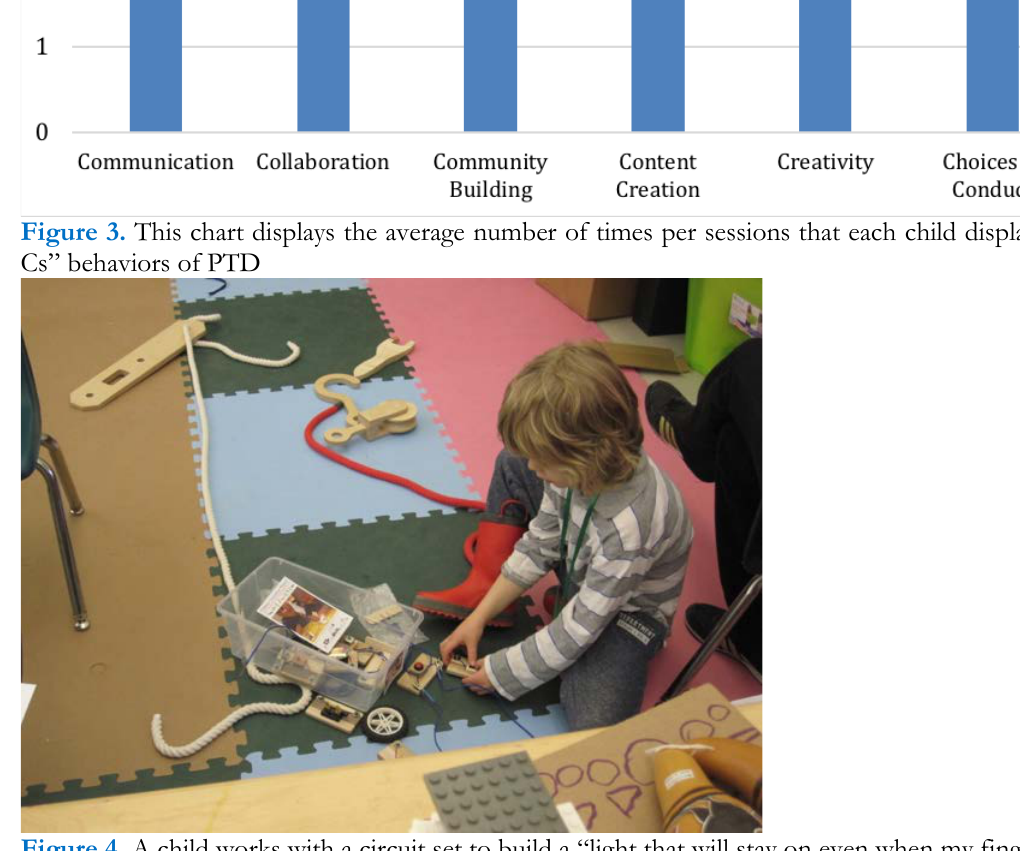
Figure 4. A child works with a circuit set to build a “light that will stay on even when my finger isn’t pushing